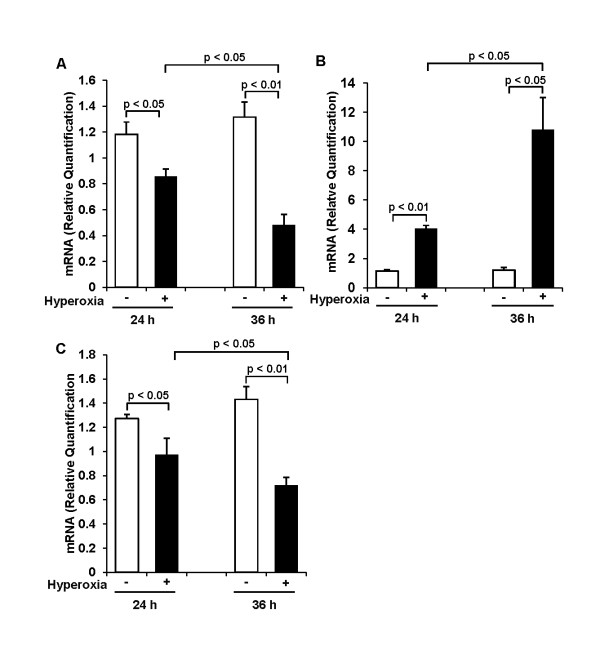
Effect of 65%-hyperoxia on VEGF and cytokine genes expression. Graphical depiction showing that 65%-hyperoxia upregulates VEGF (A) and IL-8 genes (B) and downregulates IL-10 (C) gene. The results of IL-8 and IL-10 are represented as the mean ± SD from 3 different experiments, and the results of VEGF are represented as the mean ± SD from 6 different experiments.